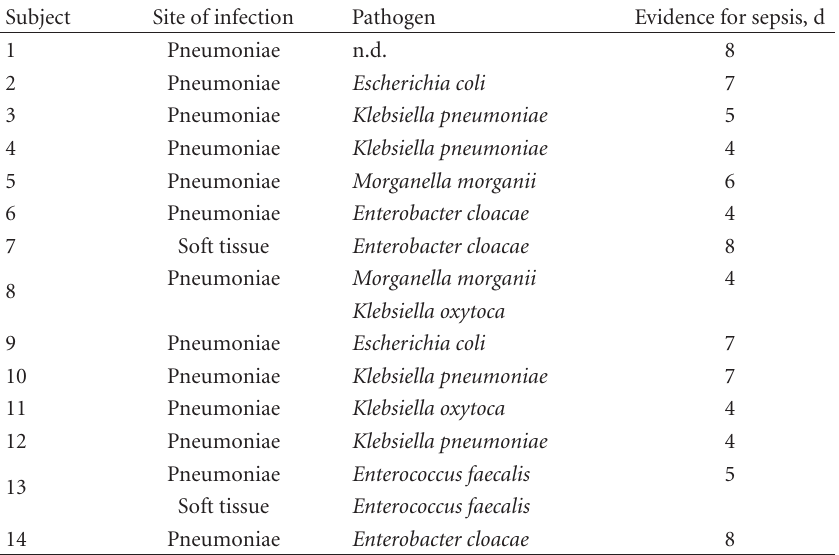
Table 1: Infection site of sepsis and microbiological